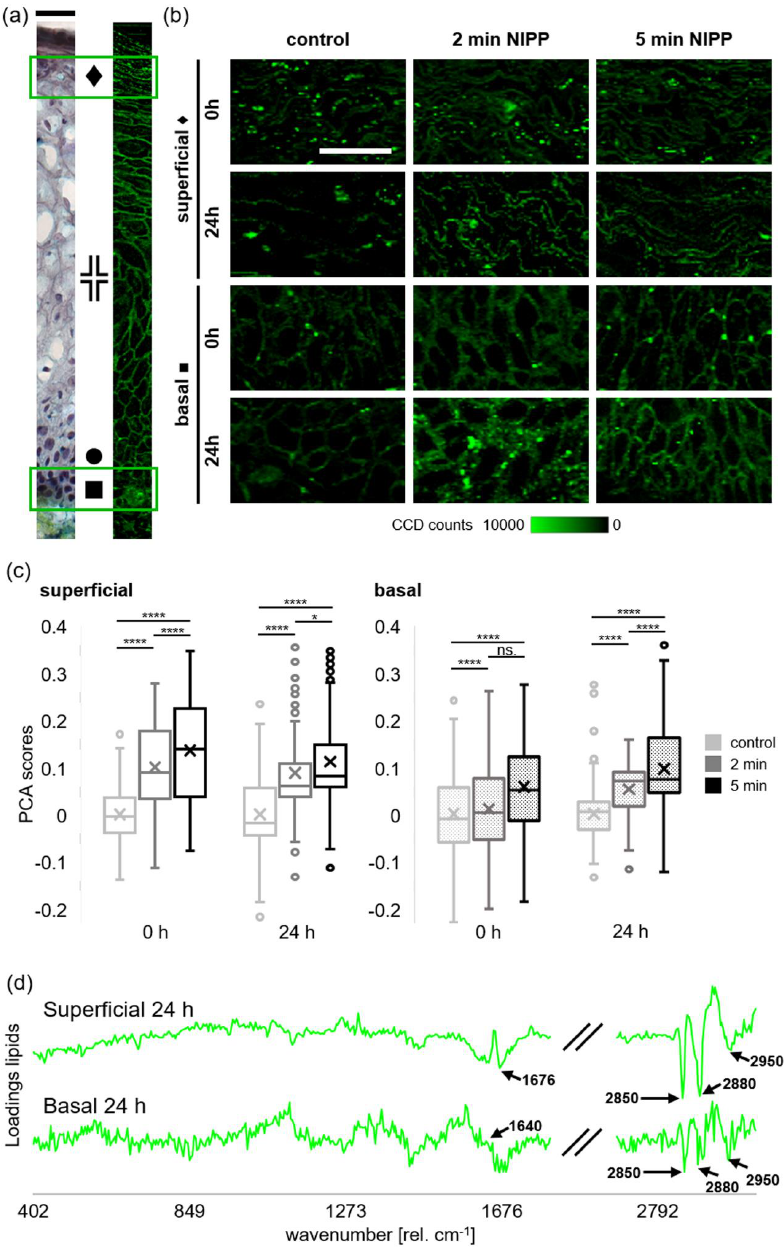
Figure 5. Raman imaging and molecular analysis of lipid components in NIPP-treated human cervical mucosa. ( a ) Staining by Movat Pentachrom histochemistry (left) and Raman imaging of lipid components (right) of native epithelial tissues; ( b ) ♦ = superficial, ╬ = intermediar, ● = parabasal, ■ = basal tissue layer. Raman images of lipid components (green) of NIPP treated and argon control samples analyzed by true component analysis (TCA). The scale bar equals 20 µ m; ( c ) Boxplot analysis of principle component analysis (PCA) scores ( n = 3) comparing lipid e ff ects in superficial and basal cell layers respectively after 2 and 5 min of superficial NIPP- or argon control-treatment after 0 and 24 h of incubation; ( d ) Representative loading plots of superficial and basal lipid components based on respective PCA scores after 24 h of incubation. The results are expressed as the mean ± SD of PCA scores. * p < 0.05, **** p < 0.0001, as determined by Two-way ANOVA and Sidak’s multiple comparisons